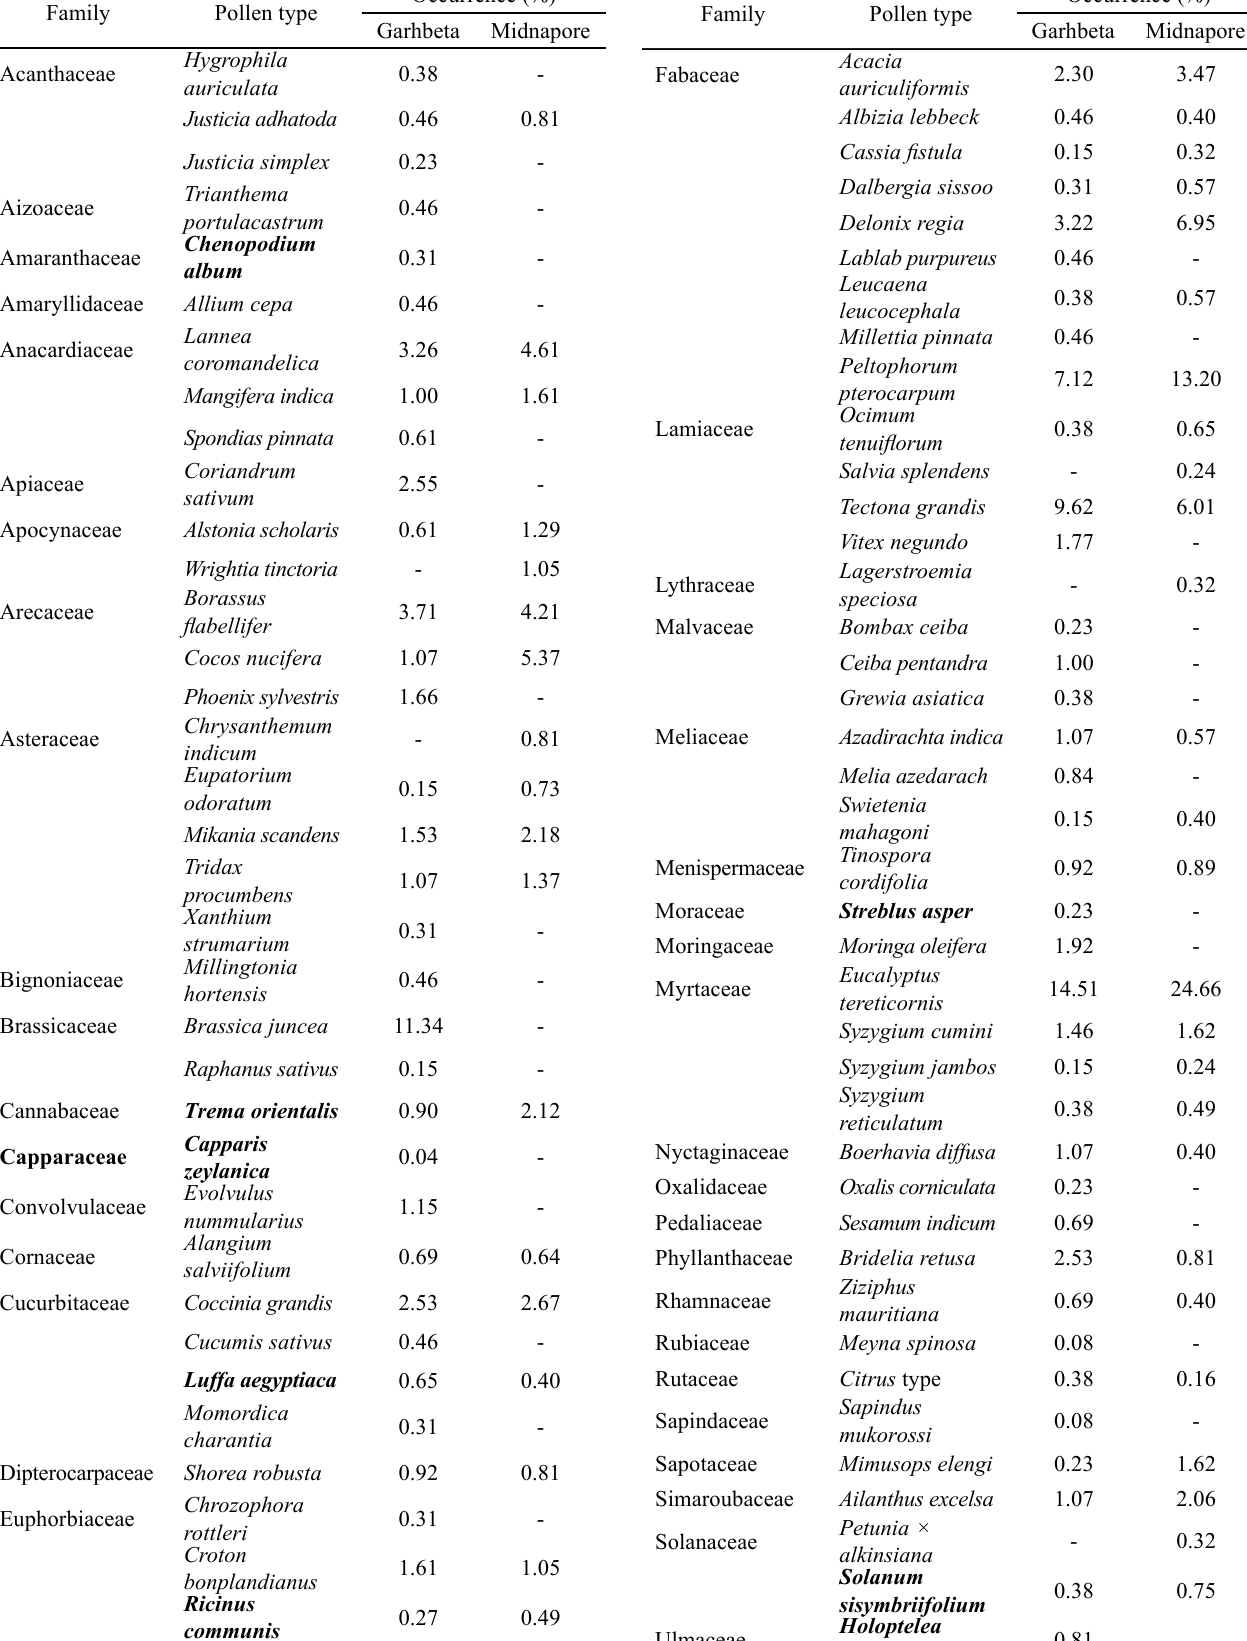
Family Pollen type